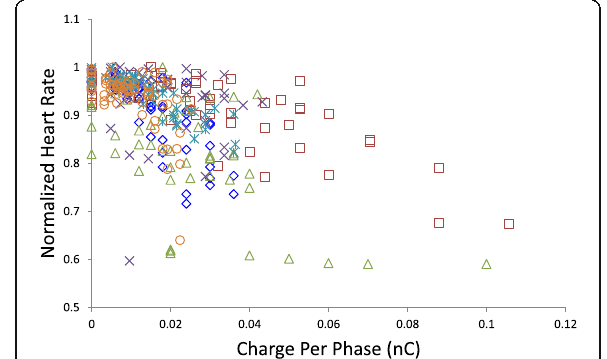
Fig. 3 Stimulus intensity-heart rate profiles. The recorded normalized heart rate during stimulation trials was plotted against the stimulus charge per phase for all animals ( n =6, animals represented by different markers). There was generally an intensity threshold for eliciting a heart rate drop that differed among animals. The change in heart rate per change in charge also differed. Data from all animals were included without omissions, and data from all waveforms are pooled. Because stimulus charge per phase is the product of pulse width and amplitude, charge was used to represent stimulus intensity